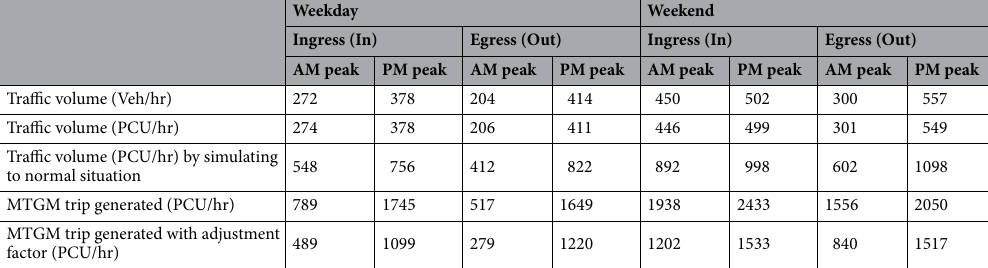
Table 8. Traffic volume at the 4th MXD site (Site D) and comparison with an adjustment